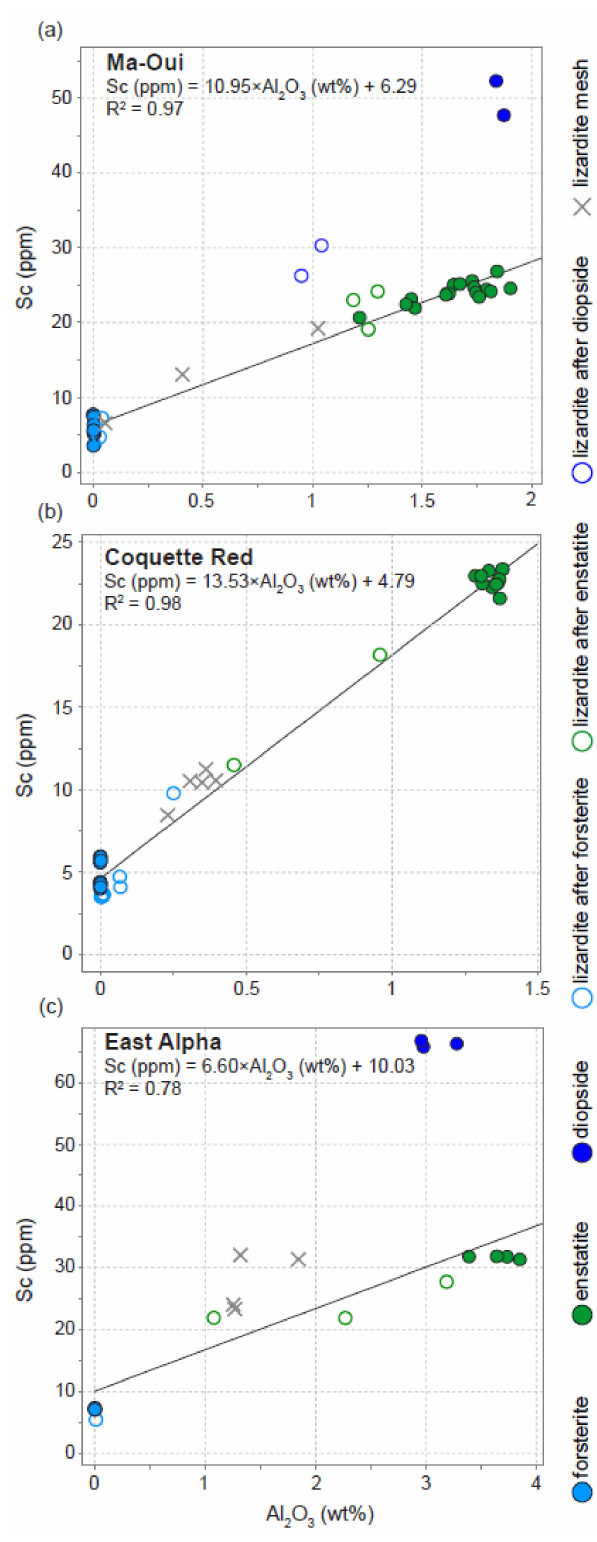
Figure 7. Sc-Al 2 O 3 scatterplots and regression lines obtained for mantle silicates (forsterite, enstatite, diopside) and lizardite (developed after forsterite, enstatite, and diopside, or as mesh) in peridotite bedrocks from ( a ) Ma-Oui, ( b ) Coquette Red, and ( c ) East Alpha from LA-ICP-MS analyses. The regression line modelling excluded accessory phases (diopside, lizardite developed after diopside, and chromiferous